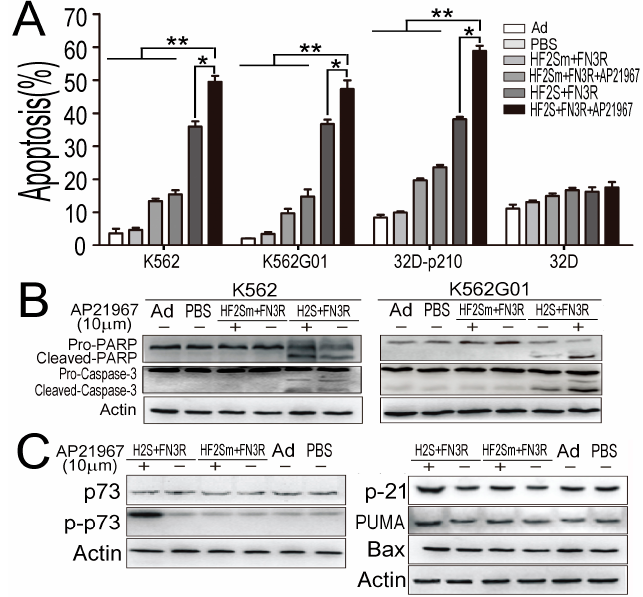
Figure 5. Nuclear located Bcr-Abl induced CML cells apoptosis by activation of p73 and its downstream molecules: The K562, K562G01 and 32D cells were, respectively, treated with